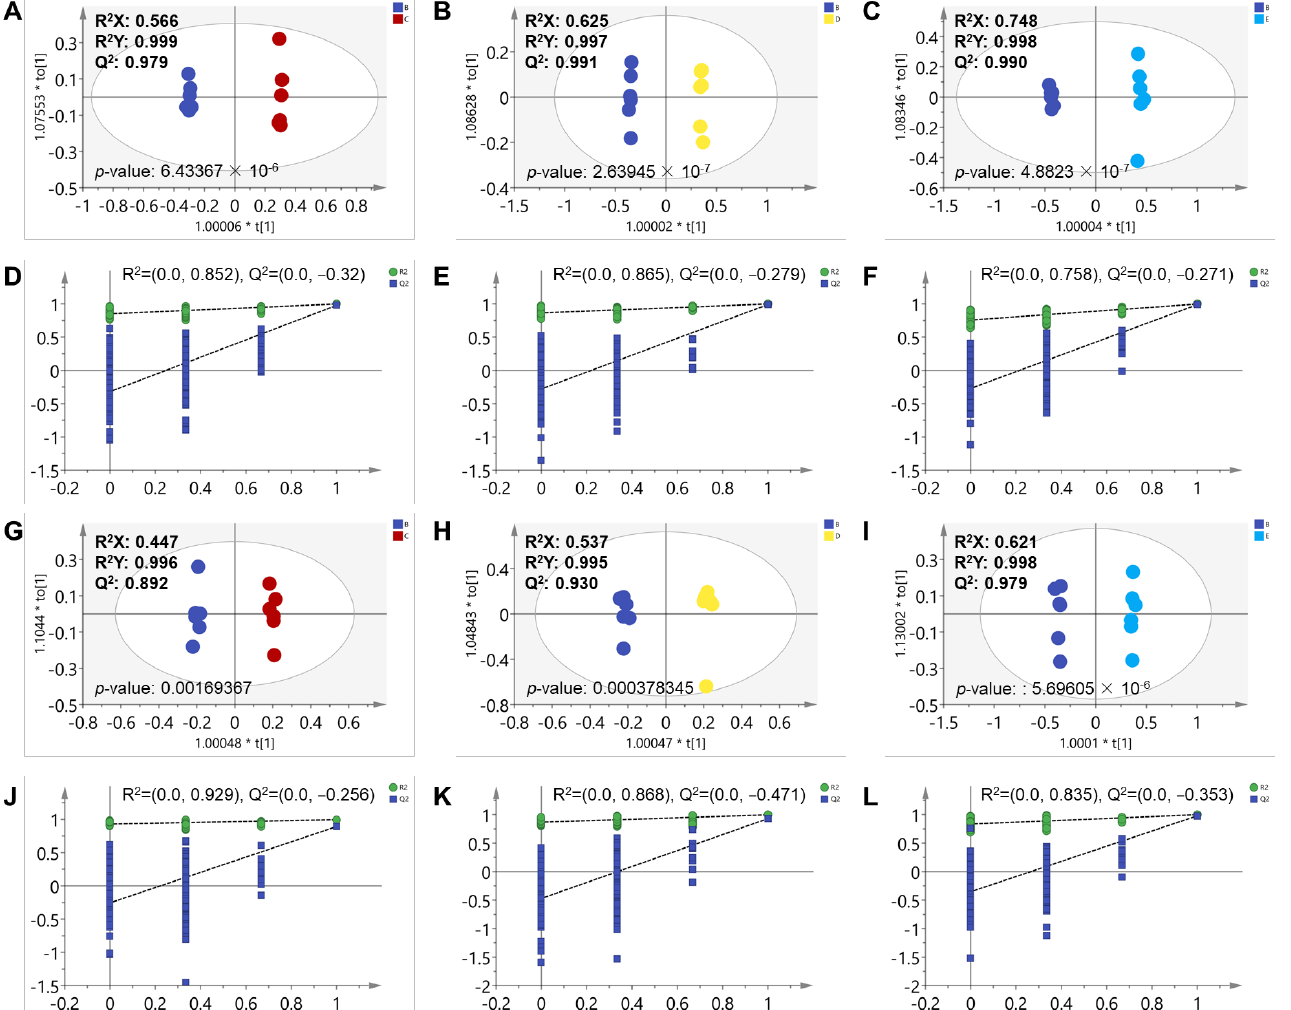
Figure 2. OPLS-DA ( A – C , G – I ) and permutation analysis (200 times) ( D – F , J – L ) derived from UHPLC-MS/MS analysis for the solvent control and scopoletin exposure groups. Data were acquired by negative ionization ( A – F ) and positive ionization ( G – L ). In the OPLS-DA model, blue points represent the solvent control group, red points represent the 1/9 MNLC of scopoletin-treated group, yellow points represent the 1/3 MNLC of scopoletin-treated group, and baby-blue points represent the MNLC of scopoletin-treated group.